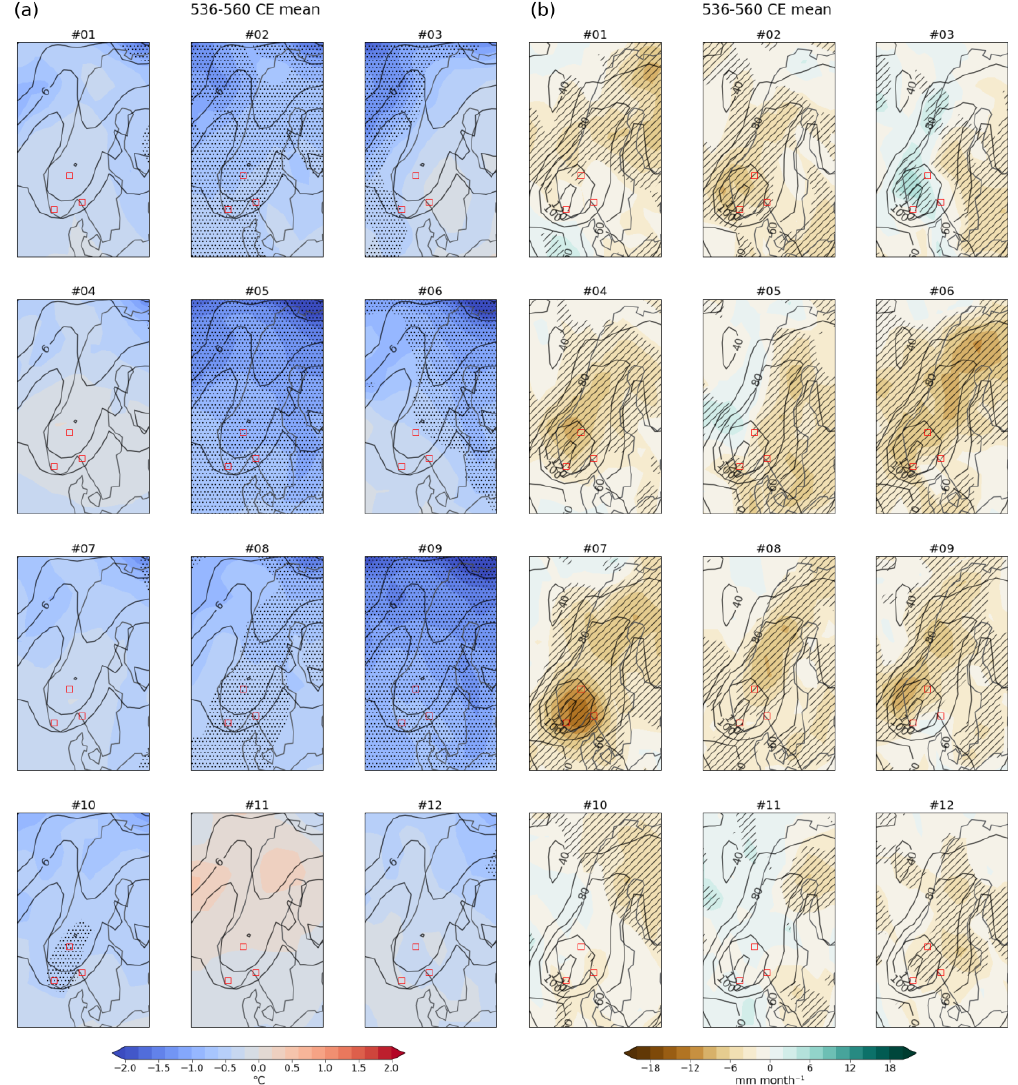
Figure 5. (a) Temperature and (b) precipitation anomaly maps for the mean growing season (536–560CE) for the individual ensemble members. Anomalies are calculated with respect to 1–1850CE climatology, which is given in contours. The red squares indicate the locations of the local sites used for the GDD modeling. The 1 σ (2 σ ) significant areas are hashed (stippled) for precipitation (2m air